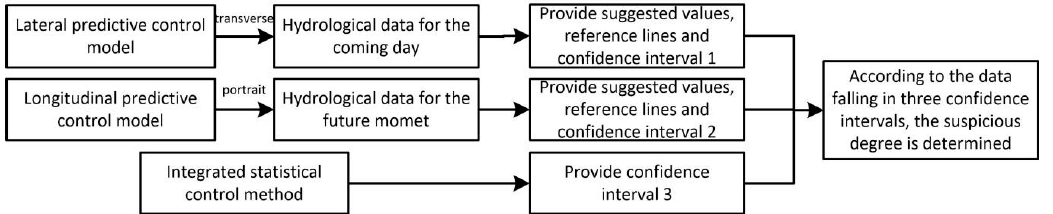
Figure 2. Continuous data quality control flow chart.